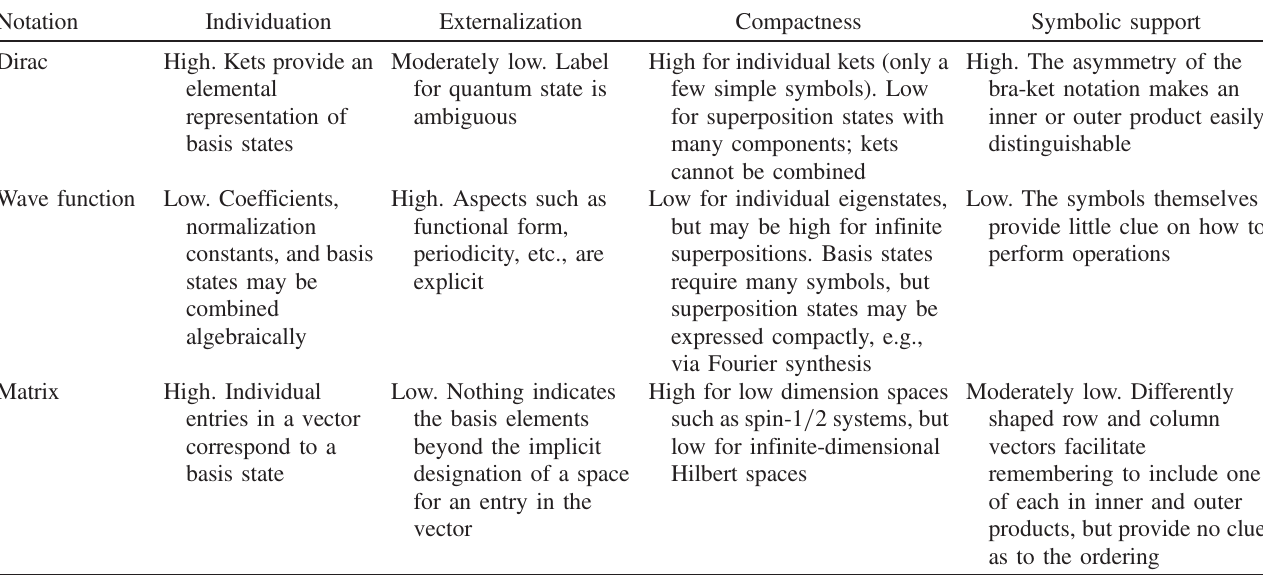
TABLE I. Summary of the characteristics of individuation, externalization, compactness, and symbolic support for computation as they are manifest in notational systems for quantum